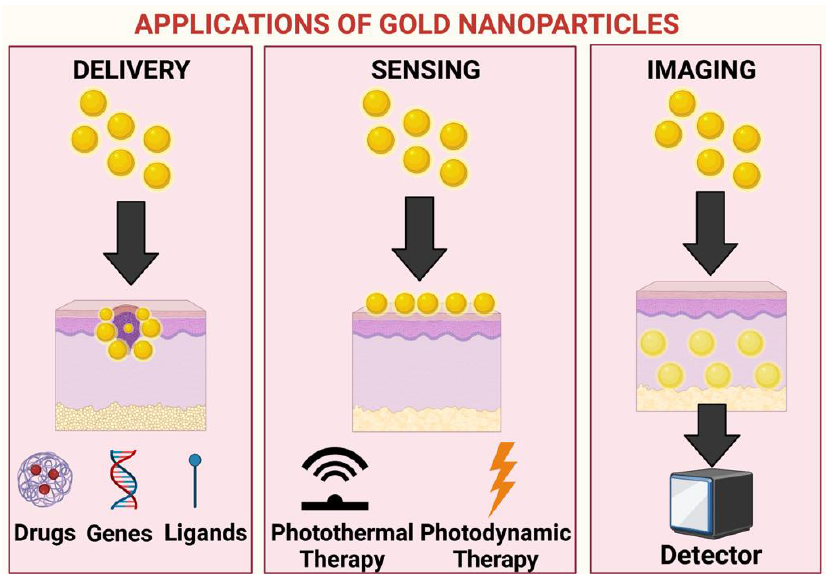
Figure 2. Extent of penetration following administration of gold NPs and their possible biomedicinal applications (created using Biorender.com, accessed on 10 January 2022).